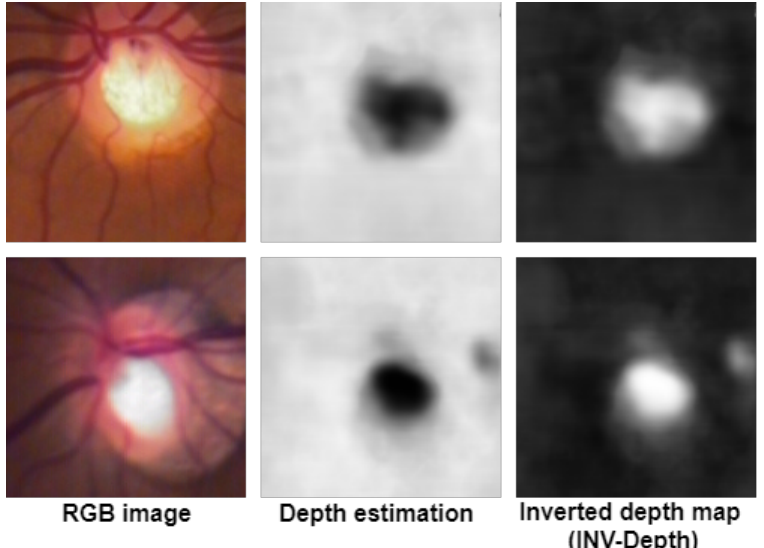
Figure 6. Depth estimation from the optic